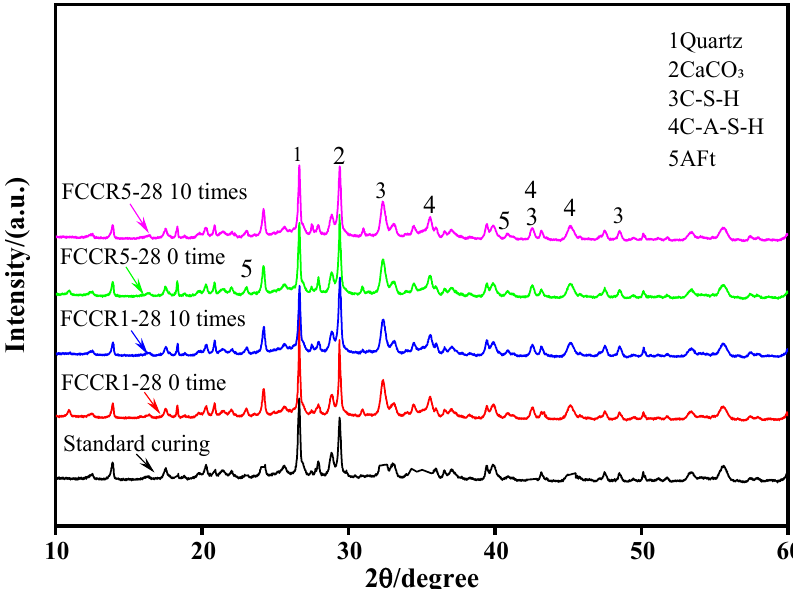
Figure 10. XRD pattern at 28 d of curing time under different durability conditions.